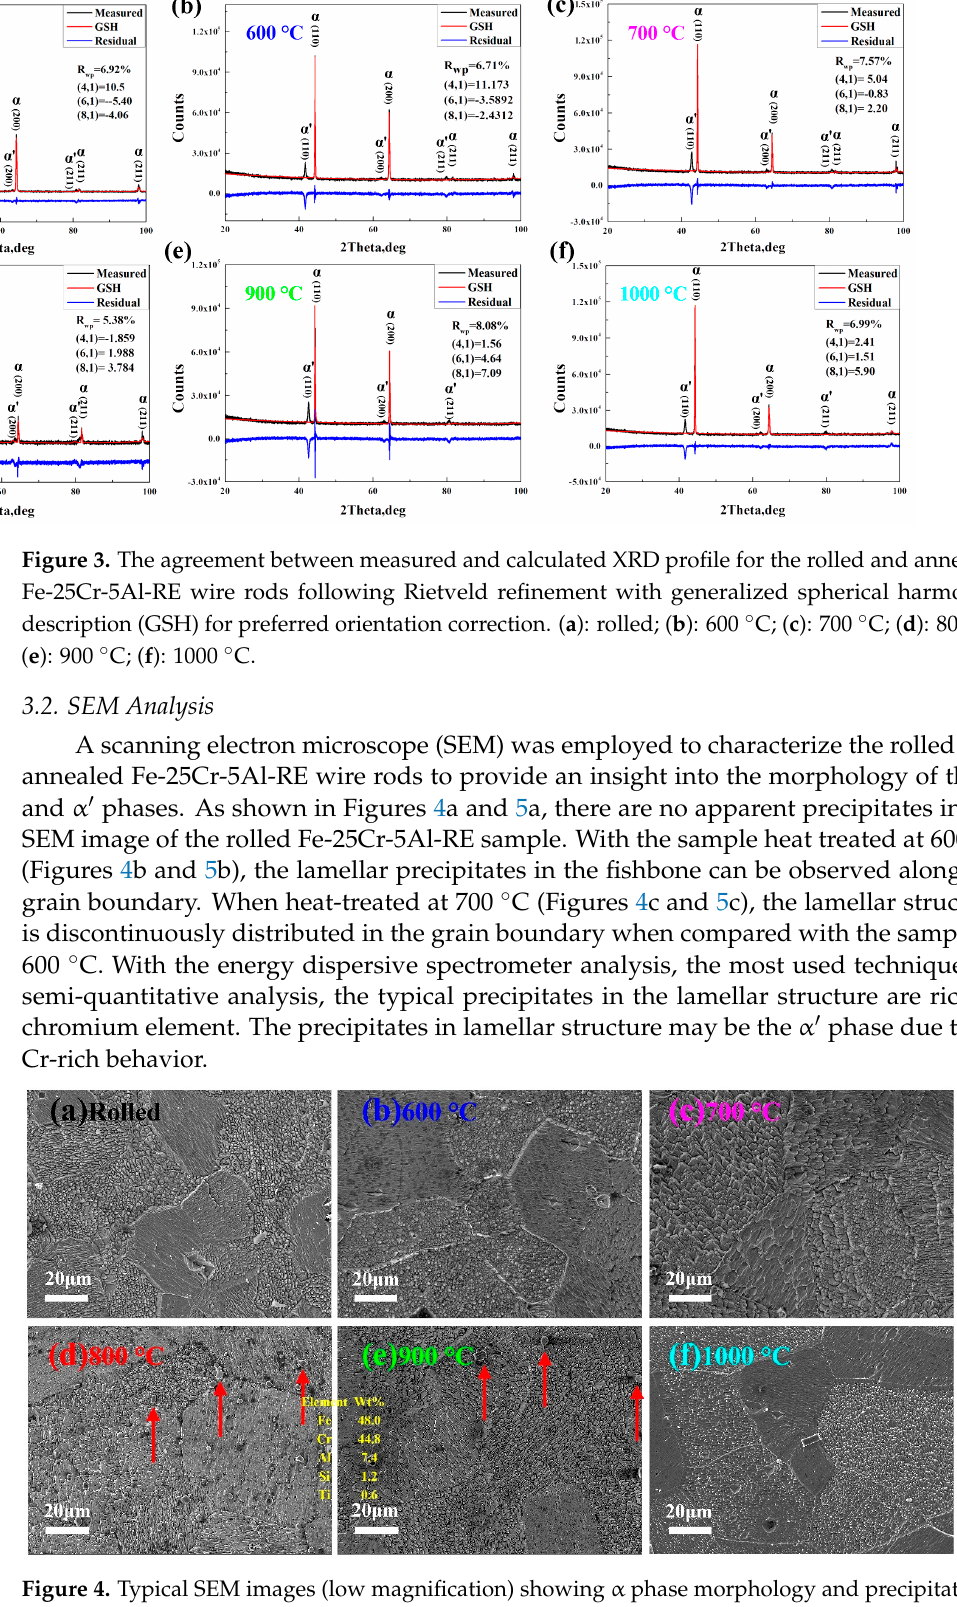
Figure 5. Typical SEM images (High magni fi cation) showing α phase morphology and typical pre- cipitates in the rolled and heat-treated Fe-25Cr-5Al-RE wire rod. ( a ): rolled; ( b ): 600 °C; ( c ): 700 °C; ( d ): 800 °C; ( e ): 900 °C; ( f ): 1000 °C. When the heating temperature increased to 800 °C (Figures 4d and 5d), no visible precipitates in the lamellar structure could be detected. Yet, the round precipitates (marked with red arrows) in a few microns can be observed both in the grain and along the grain boundary. When heat-treated at 900 °C, the number of micro-sized precipitates was less than that at 800 °C. As con fi rmed by the EDS technique, the typical micro-sized precipitates in sphere morphology were also rich in chromium elements but continued to have more aluminum elements. As shown in Figures 4f and 5f, there were no apparent precipitates in the lamellar structure and micro-sized sphere when heat-treated at 1000 °C. The large precipitates (mark in TiN) with sharp edges can be reckoned as titanium nitride (TiN) [20]. 3.3. TEM Analysis